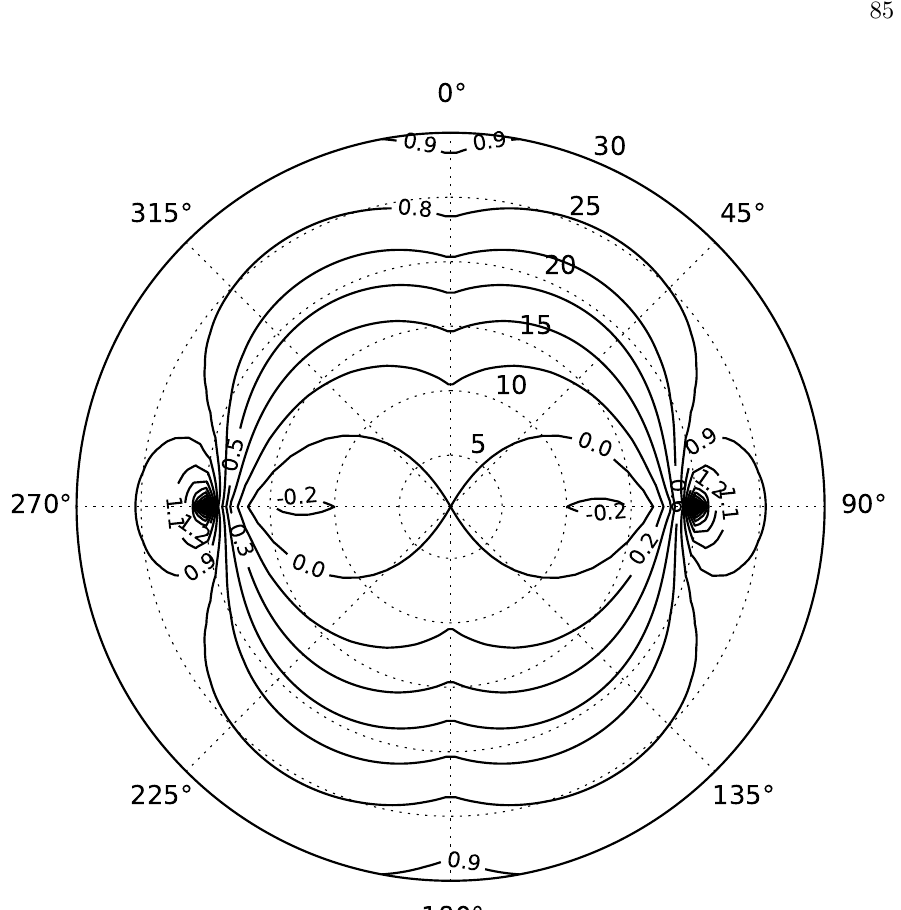
Fig. 2. Isolines of the correction factor of the radial gravity, C D , being the radial gradient of gravitational potential. The coordinates are the same as in Figure 1. Sim- ilarly to the gravitational potential, in the outer region free of isolines the value of C D asymptotically approaches to 1.0, and the central value of the correction factor is